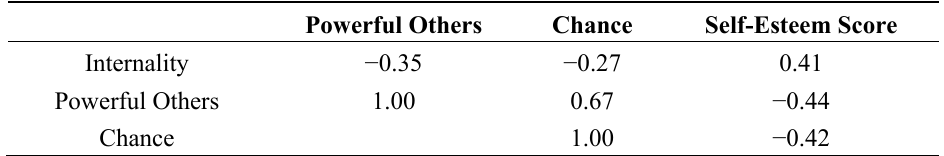
Table 3. Intercorrelations of the Multidimensional Locus of Control IPC Scale questionnaire and correlation coefficients of its dimensions with the self-esteem scale.